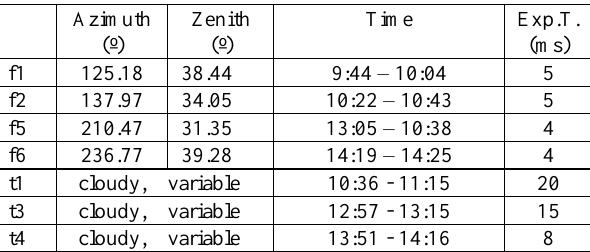
Table 3. Spectral settings (peak wavelength and FWHM) UAV data